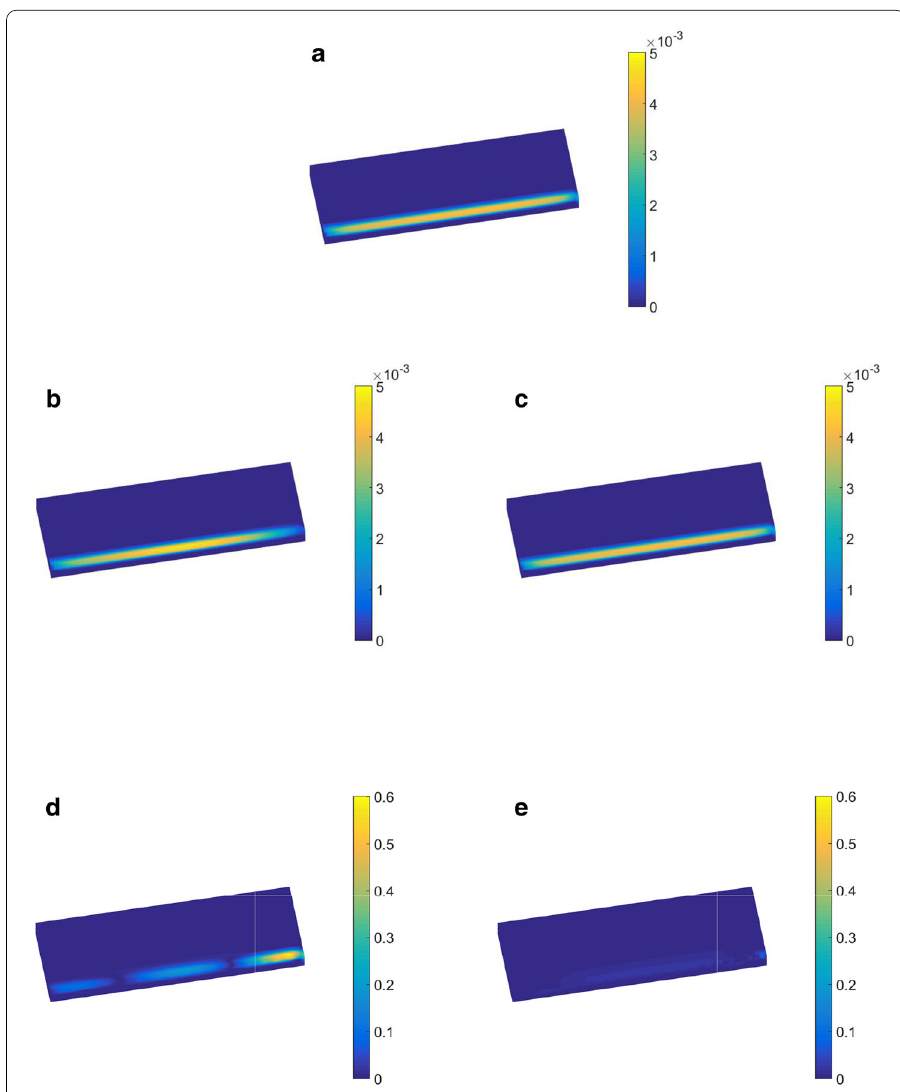
Fig. 2 Equivalent plastic strain field comparisons [reference calculations ( a ) and online Lagrange ( b and d ) and Grassmann ( c and e ) interpolation]. a Solution from full FE computations. b Solution rebuilt by RBs interpolated with the Lagrange interpolation. c Solution rebuilt by RBs interpolated with the proposed method. d Local error resulted from RBs interpolated with the Lagrange interpolation. e Local error resulted from RBs interpolated with the proposed method